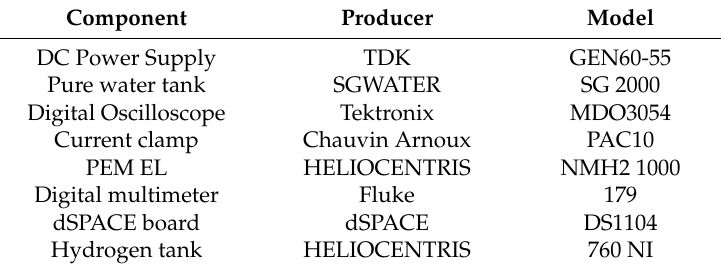
Table 2. Components of the measurement